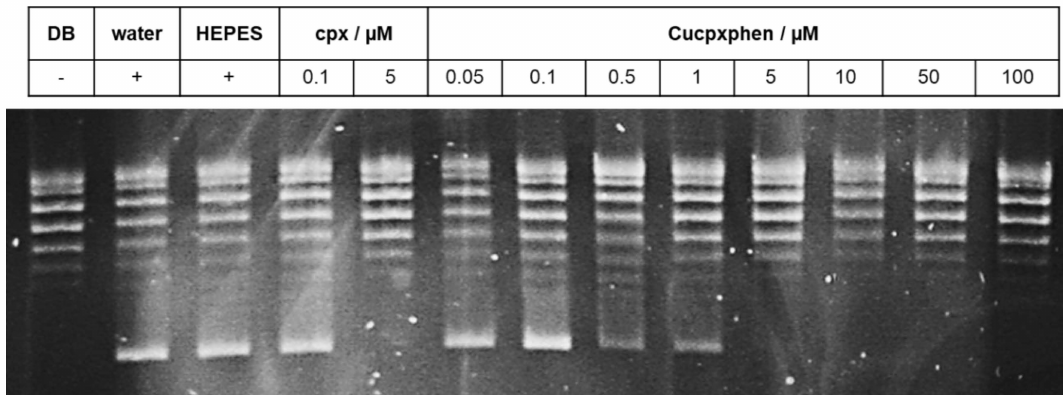
Figure 1. DNA gyrase supercoiling inhibition assay obtained for Cucpxphen as enzymatic inhibitor of the E. coli DNA gyrase, performed with 0.5 µ L of relaxed pBR322 plasmid, determined in a 1% (w / v) agarose gel in TAE bu ff er. DB is dilution bu ff er and the respective band is the negative control, containing the relaxed plasmid in the absence of the enzyme. Water and HEPES are the positive control bands containing the enzyme and the plasmid. The cpx bands represent the drug control. µ M means µ mol dm − 3 and refers to the concentration of the compound. The experiment was also performed with the S. aureus DNA gyrase supercoiling assay kit (Figure S3 of the Supplementary Material). The enzymatic inhibitory activity of Cucpxphen and Cuspxphen was evaluated for both bacterial species.